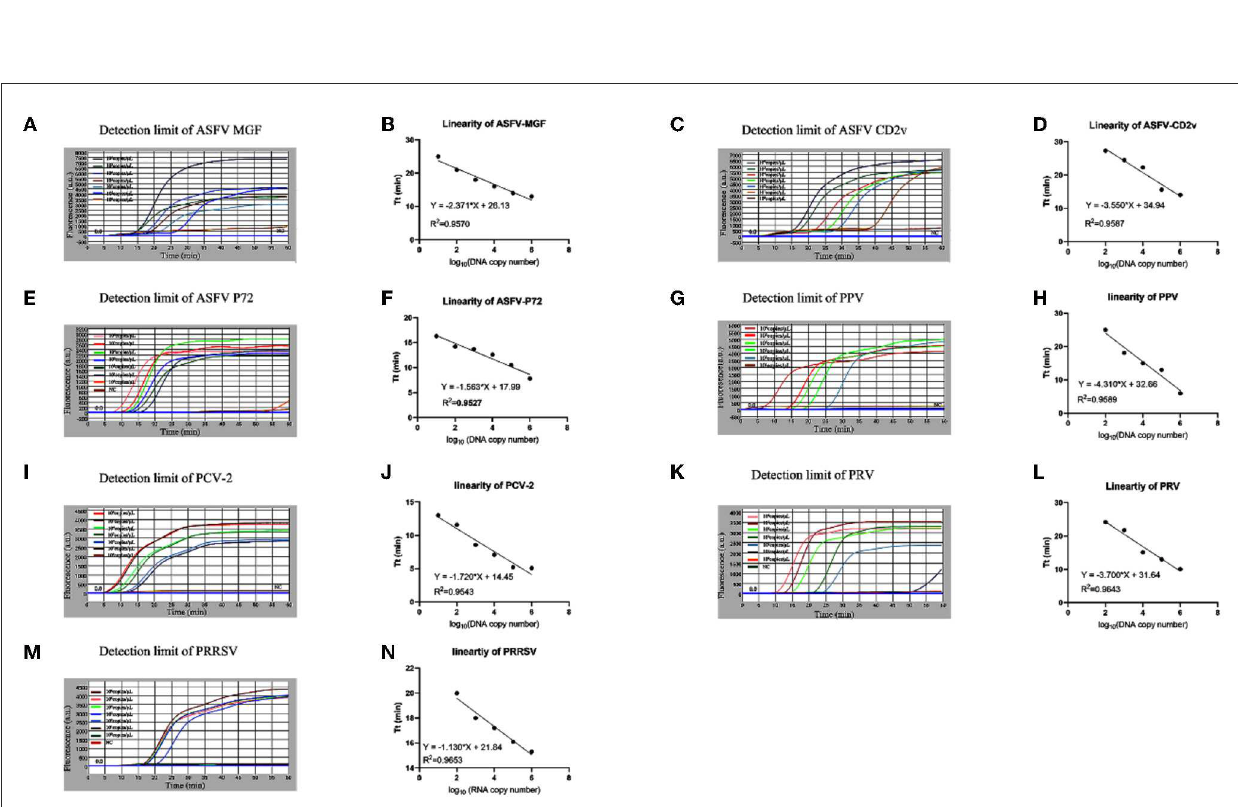
FIGURE4 Sensitivity test of the microfluidic-LAMP chip detection system for five swine pathogens. (A–N) All tests were carried out using gradient-diluted standard plasmid of each pathogen. Semi-logarithmic regression between the Tt values and standards concentration by GraphPad Prism 8.3.0.